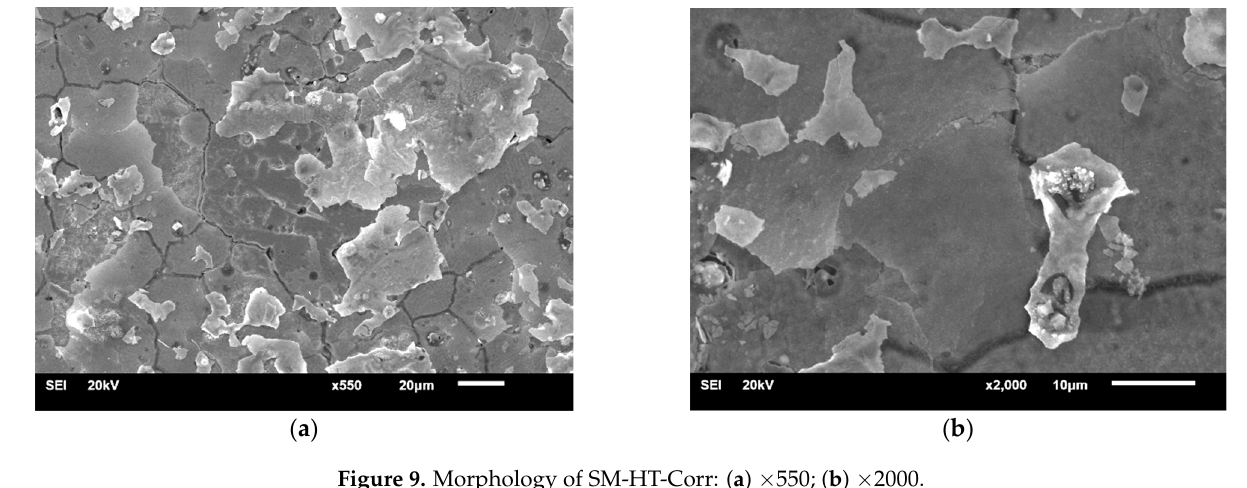
Figure 9. Morphology of SM-HT-Corr: ( a ) ×550; ( b ) ×2000.